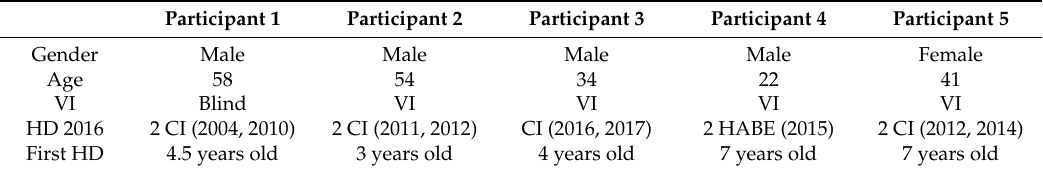
Table 1. Participants’ background information, including their visual and hearing